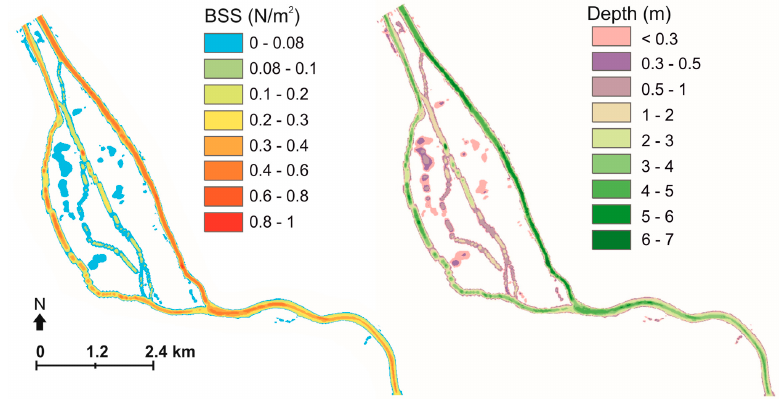
Figure 5. The distribution of BSS ( left ) and depth ( right ) during a low discharge case of the control period. The areas with bed shear stress lower than 0.08 N / m 2 , which is the critical value for the initiation of movement of the D 50 gains, is marked with blue